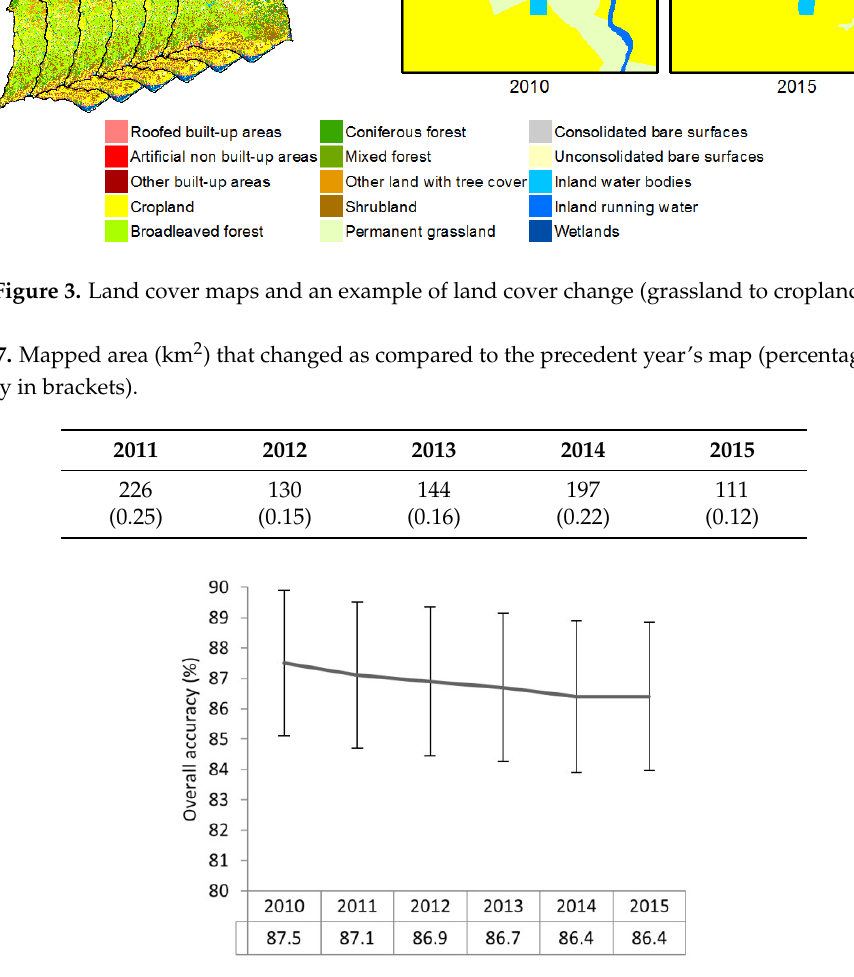
Figure 4. Estimated overall accuracy of the maps with a 95% confidence interval.